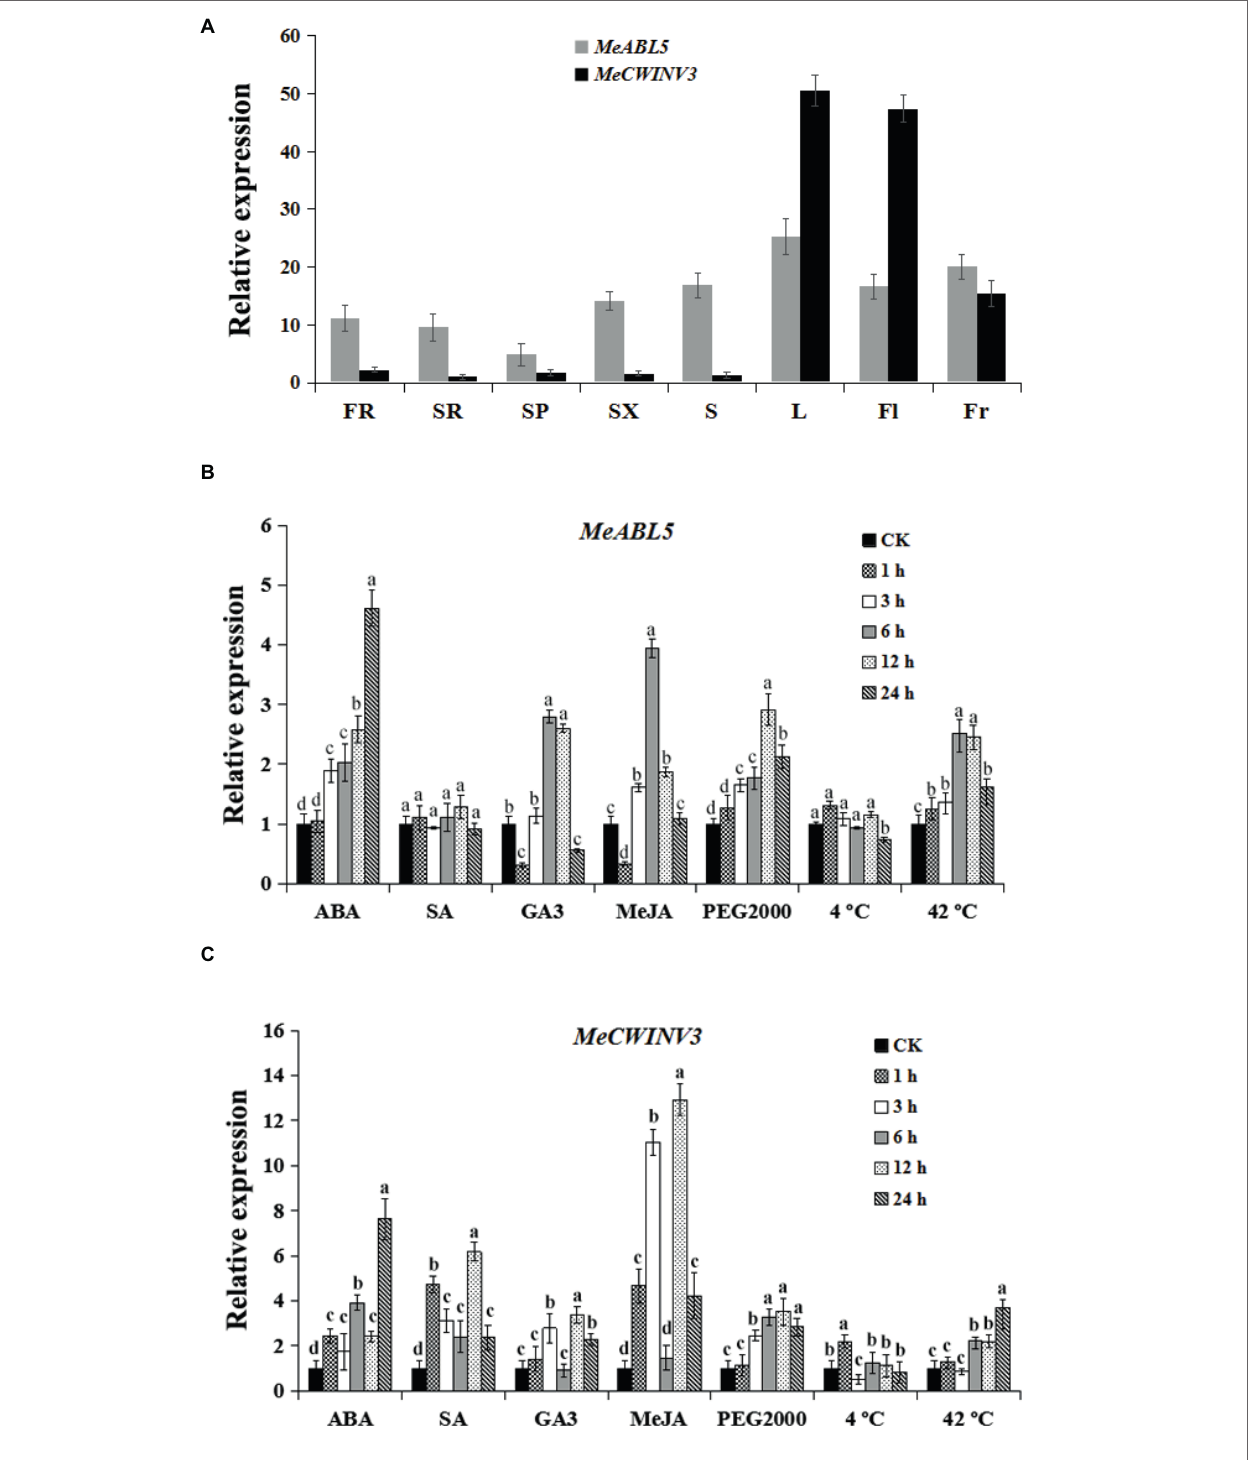
FIGURE 9 | Expression pattern analysis of MeABL5 and MeCWINV3. (A) Expression analyses of MeABL5 and MeCWINV3 in cassava organs or tissues using qRT-PCR. FR, fibrous roots; SR, storage roots; SP, storage root phloems; SX, storage root xylems; S, stems; L, leaves (the seventh or eighth leaves from the top of the stem); Fl, flowers; Fr, fruits. The expression of MeCWINV3 in storage roots (SR) was used as a calibrator. (B,C) Expression patterns of MeABL5 (B) and MeCWINV3 (C) respond to ABA, SA, GA3, MeJA, PEG2000 (artificial drought condition), cold (4°C), and heat (42°C). Forty-five-day-old SC8 plantlets under different treatments were used for the analyses. The plantlets without any treatment were used as the control (CK). Each value represents the mean ± SE of three independent biological replicates. Letters a–d on the error bars indicate significant differences, as assessed by ANOVA ( p <